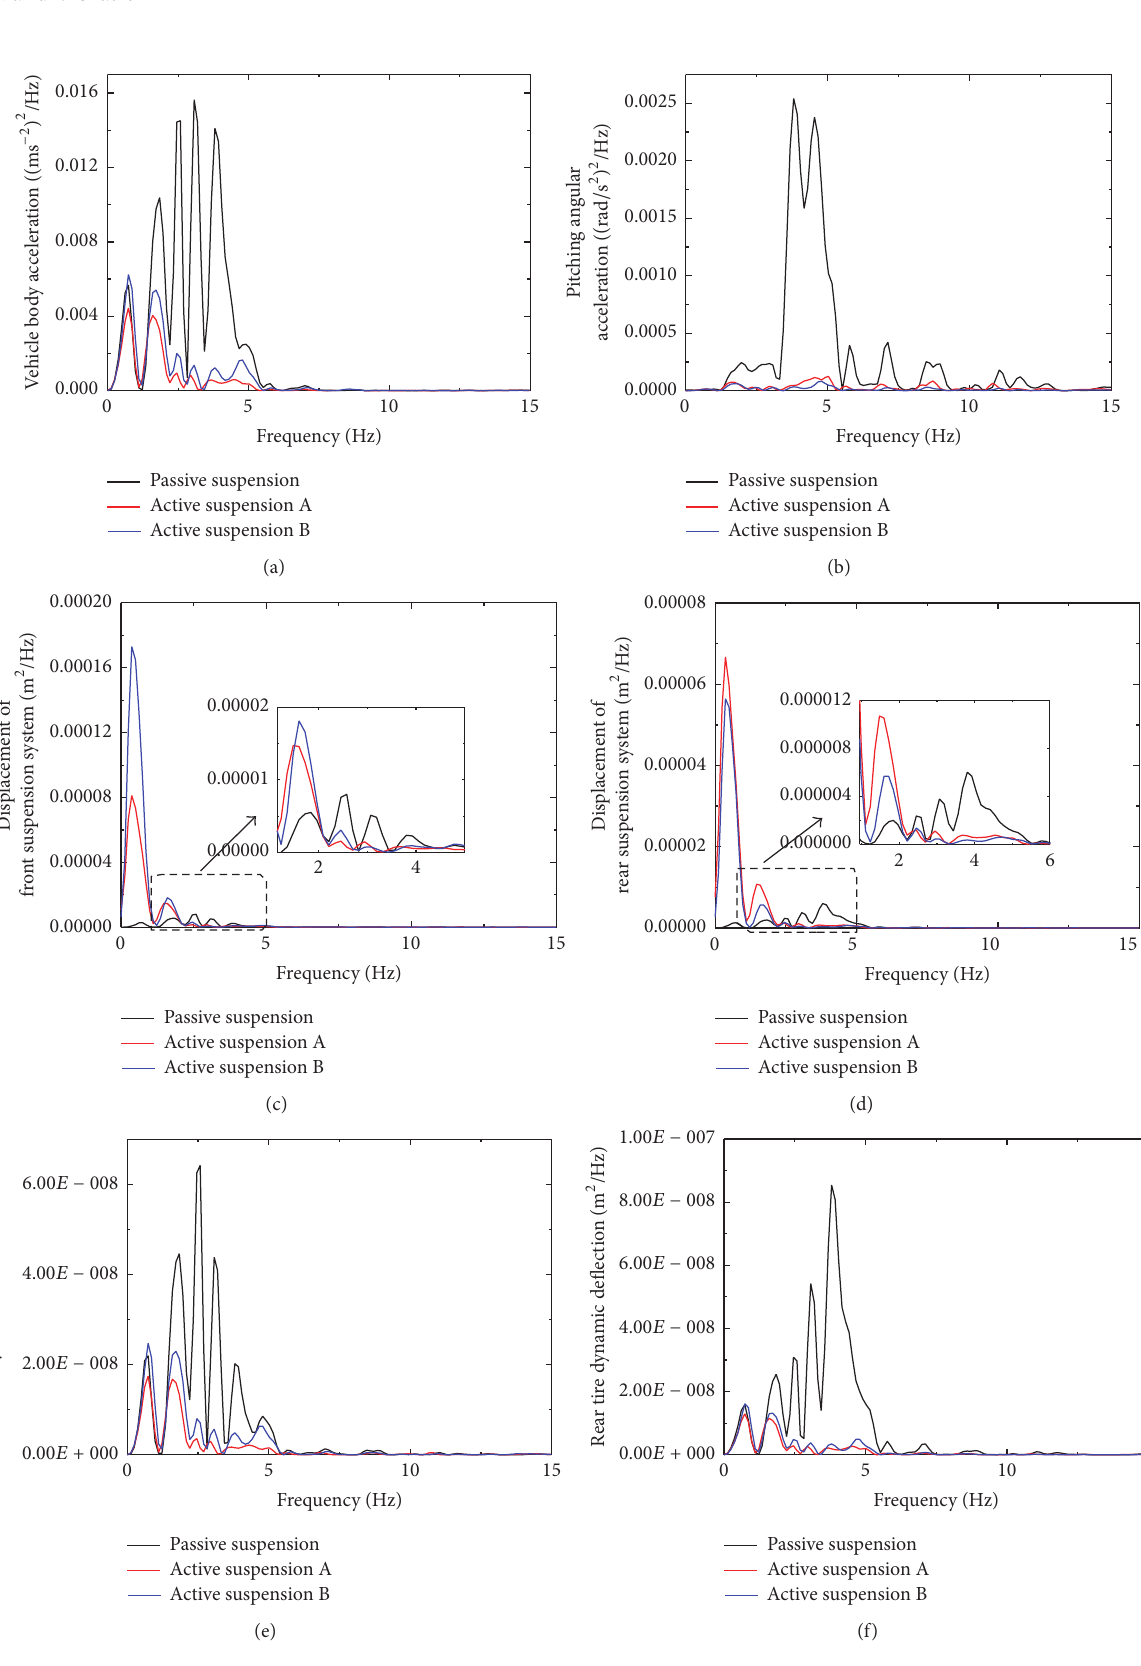
Figure 6: The PSD response to passive suspension, active suspension A, and active suspension